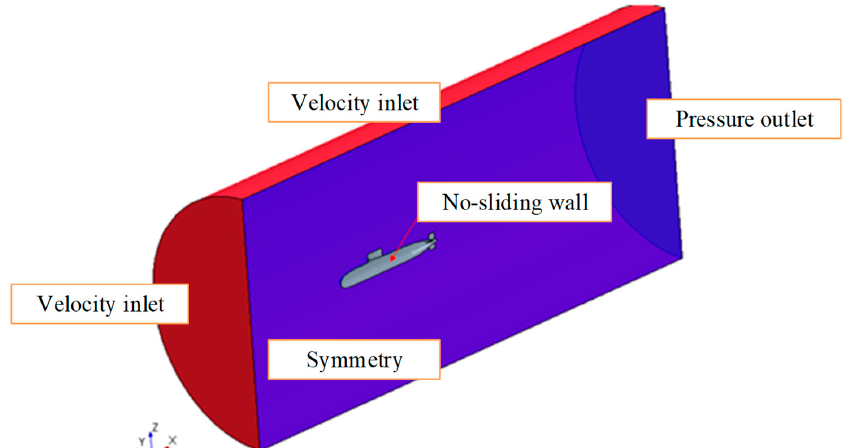
Figure 2. Calculation domain and boundary